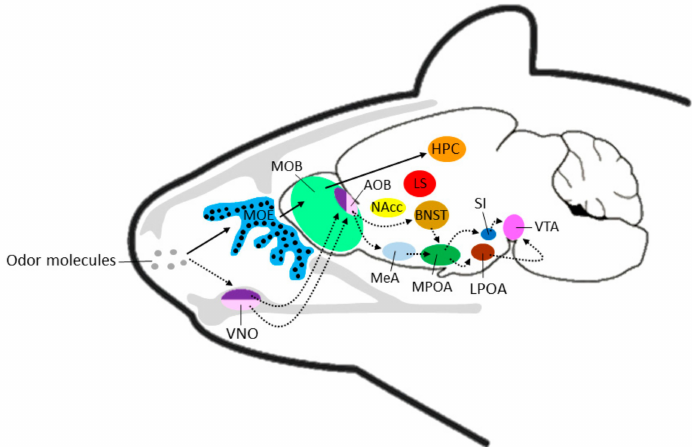
Figure 1. Schematic representation of transmission of olfactory information via the main olfactory system (solid black arrows) or the vomeronasal system (broken arrows) to corresponding brain regions. Black circles in the MOE indicate the broad localization of olfactory sensory neurons. Note: locations of brain regions not exact and for pictorial purposes only. AOB: accessory olfactory bulb; BNST: bed nucleus of the stria terminalis; HPC: hippocampus; LS: lateral septrum; MOB: main olfactory bulb; MOE: main olfactory epithelium; MeA: medial amydala; LPOA: lateral preoptic area; MPOA: medial preoptic area; NAcc: nucleus accumbens; SI: substantia innominata; VNO: vomeronasal organ; VTA: ventral tegmental